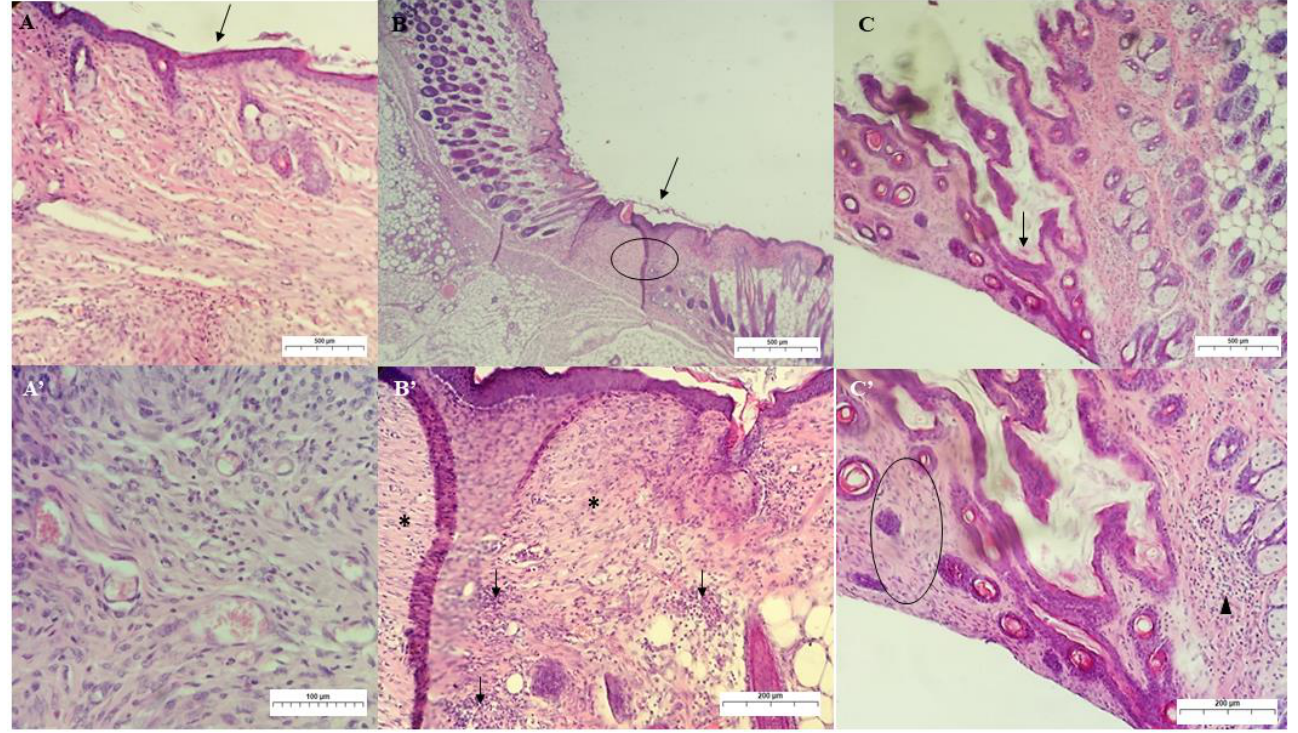
Figure 11. Photomicrograph of skin lesion in mice on the 14th day of treatment. ( A ): Re-epithelization (arrow) of the wound treated with PS, showing in detail ( A ’ ) granulation tissue in the deep dermis with several newly formed vessels (magnification: 40 × and 200 × , respectively). ( B ) Re-epithelization (arrow) and collagenization (circle) in the dermis for the GChi-treated group, showing in detail ( B ’ ) fibroblast proliferation (asterisks) and mixed inflammatory infiltrate (arrows) (magnification: 40 × and 100 × , respectively). ( C ): Re-epithelization (arrow) of the wound treated with GChiN2, in detail ( C ’ ), collagenization and fibroblasts (circle), and presence of hair follicles and mononuclear infiltrate (arrowhead) (magnification: 40 × and 100 × , respectively). Staining by H.E. physiological serum (PS), chicha hydrogel (GChi), chicha hydrogel with 0.02 g mL −1 nerolidol (GChiN2).